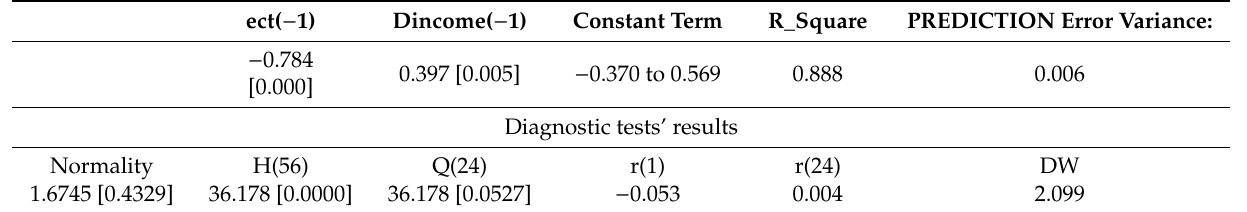
Table 7. STSM short-run estimation